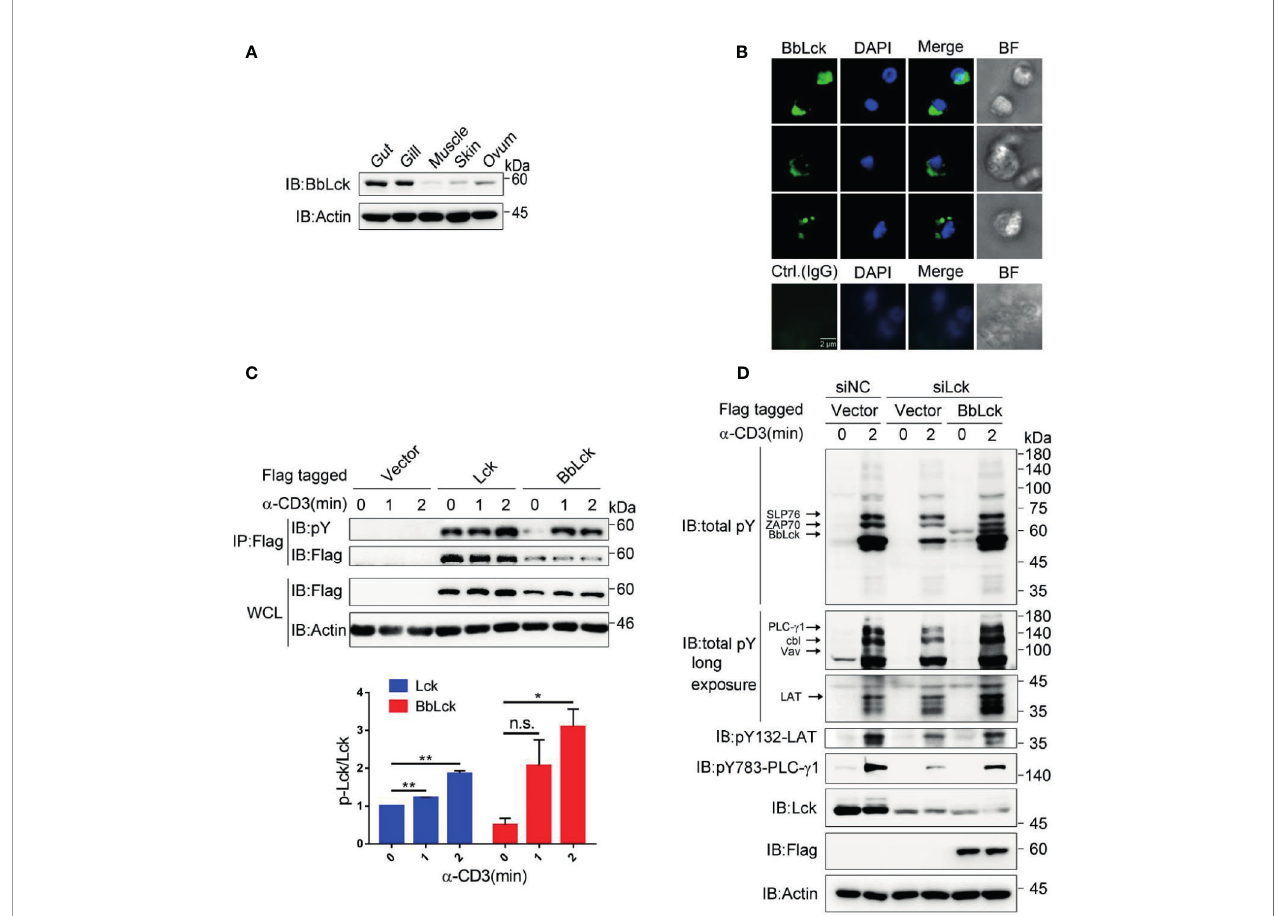
FIGURE 2 | Characterization of BbLck distribution in amphioxus and function in Jukart TAg cells. (A) Different tissue distributions of BbLck. Homemade rabbit anti- BbLck antibody was used for immunoblotting. (B) Localization of BbLck in the gut cells of an amphioxus. Single cells were separated from gut tissue and then immunostained with BbLck antibody followed by fl uorophore-conjugated secondary antibody (green). Nuclei were stained with DAPI dye (blue). Images were acquired using fl uorescence microscopy at 400× magni fi cation (scale bar,2 m m). (C) Tyrosine phosphorylation of human Lck and BbLck. The indicated plasmids were transfected into Jurkat TAg cells for 48 h, and the cells were then stimulated with anti-CD3 for the indicated times. The identity of activated Lck was con fi rmed by anti-Flag immunoprecipitation followed by pY antibody immunoblotting. The densitometric quanti fi cation of the ratio of phosphorylated Lck to immunoprecipitated Lck (the ratio for the 0 min was set as 1) is shown on the bottom. (D) Jurkat TAg T cells were cotransfected with the siRNA designed speci fi cally targeting Lck mRNA (siLck) and plasmid for 48 h, followed by stimulation with anti-CD3 for the indicated time. Whole-cell lysates (WCLs) were immunoblotted with pY antibody and the indicated antibodies. n.s., not signi fi cant; * P < 0.05, ** P < 0.01 (two-tailed unpaired t -test). The data are presented as the mean (± s.e.m.). Data are representatives of three (A, B, D) or two (C) independent